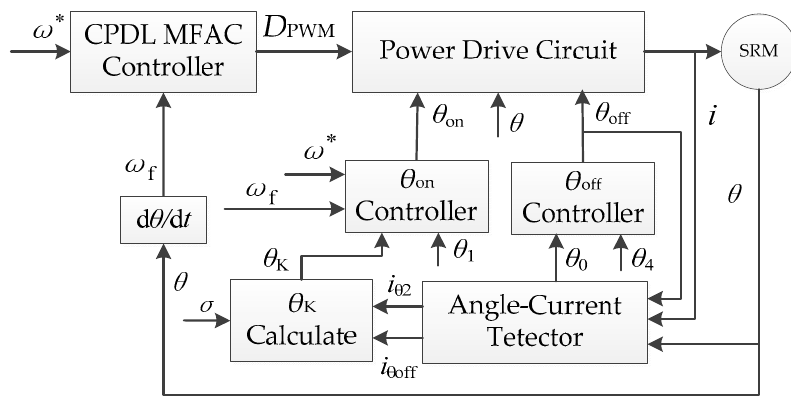
Figure 5. Closed-loop speed control system of switched reluctance motor